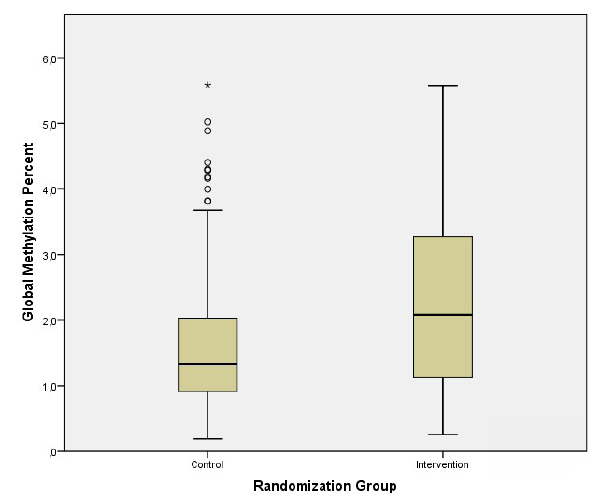
Figure 2 – Boxplots showing a comparison between the DNA methylation levels of the intervention and control groups. Data are presented as medians and range of variation. Boxes represent the intervals between the first and third quartiles. Comparison was made through a t -test for independent samples with ln-transformed values, P <